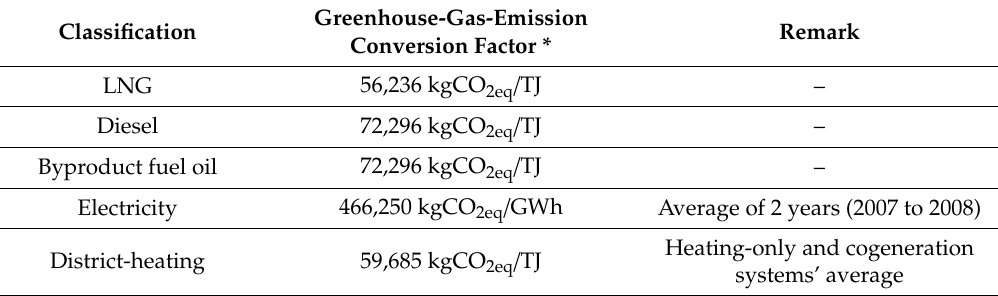
Table 10. Greenhouse-gas-emission conversion factors by fuel type.